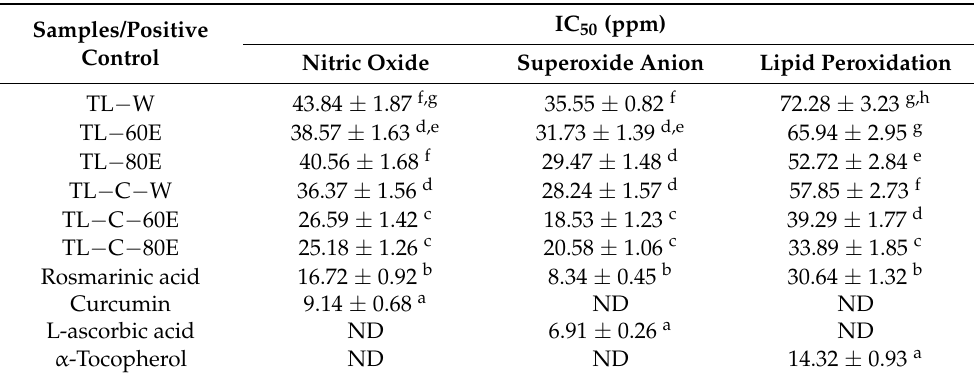
Table 3. IC 50 on nitric oxide and superoxide anion scavenging activities and inhibition effect on lipid peroxidation. IC 50 (ppm) Samples/Positive Control Nitric Oxide Superoxide